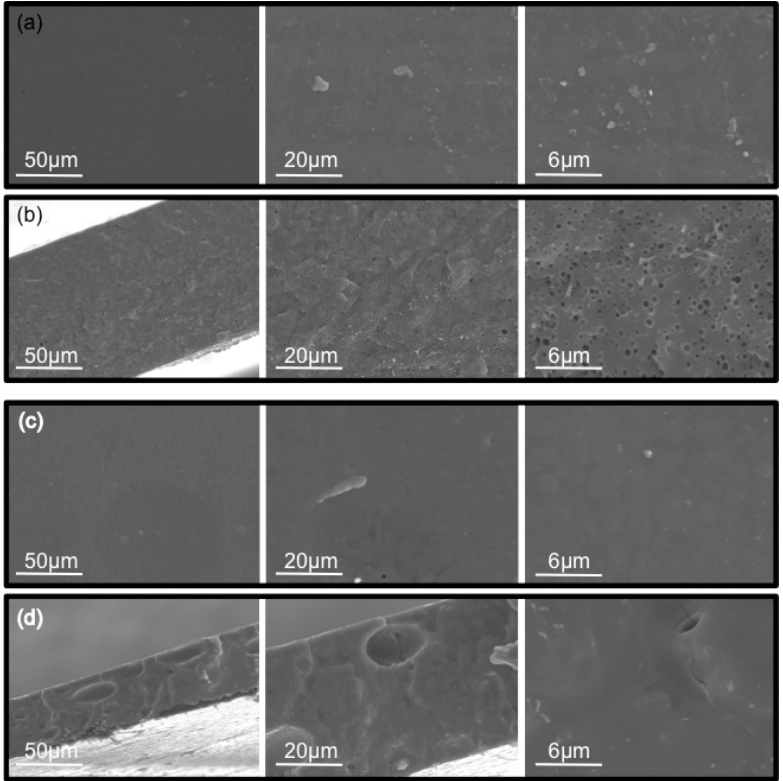
Figure 2. SEM images of PIMs prepared by thermal-compression technique. 70% TPU–30% Aliquat 336: surface ( a ), cross-section ( b ); 70% PCL–30% Aliquat 336: surface ( c ), and cross-section ( d ).